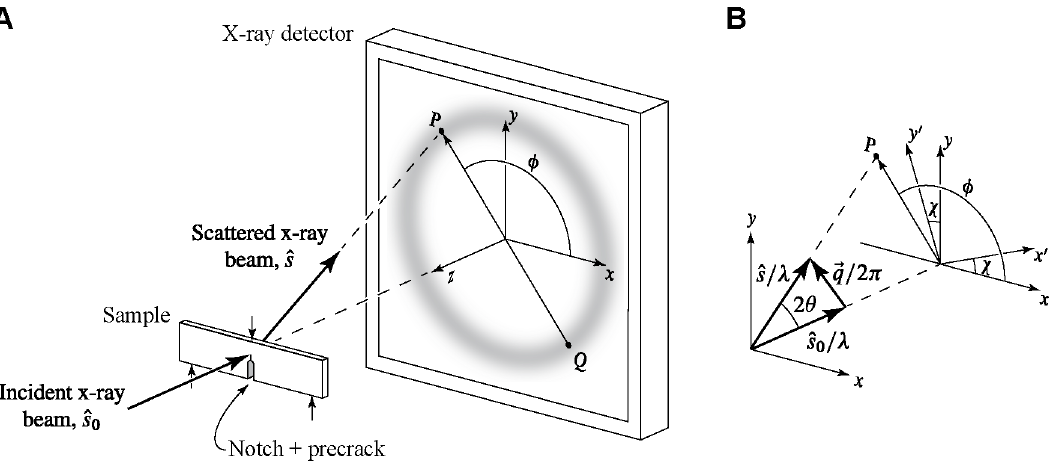
Figure 9. Experimental geometry and coordinate systems for the insitu studies of fracture. (a) The single-edge notched bend (SENB) specimen is loaded in three-point bending using a load frame that can be translated in both horizontal ( x ) and vertical ( y ) directions. A high-energy x- ray beam with a cross section of 50 m m | 50 m m is used to produce transmission scattering patterns as a function of position relative to the crack tip. From changes in the diameter of the scattering ring PQ the strain as a function of orientation w relative to the laboratory ( x {{ y ) coordinate system can be determined. (b) Structural information comes from a direction determined by the scattering vector ~ qq . Because 2 h is small ( v 5 0 ), ~ qq lies nearly in the x – y plane, allowing determination of the normal strains E xx and E yy as well as the shear strain E xy . The principal axes of strain x 0 {{ y 0 are oriented at an initially unknown angle x relative to the laboratory ( x {{ y ) coordinate system. No information is available about the strain components in the z {{ z 0 direction parallel to the incident beam.